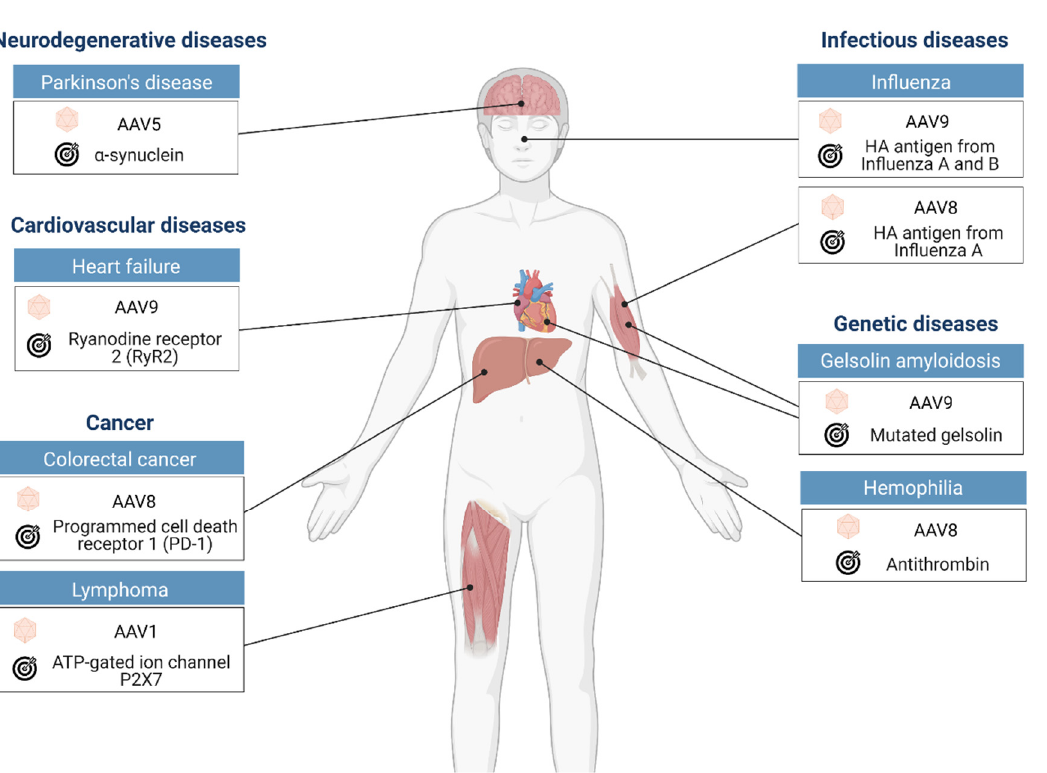
Figure 2. Therapeutic applications of AAV-mediated nanobody gene delivery in preclinical studies discussed in this review. For each study, this figure illustrates the disease model, the AAV serotype used, the target organ, and the target of the therapeutic nanobodies.